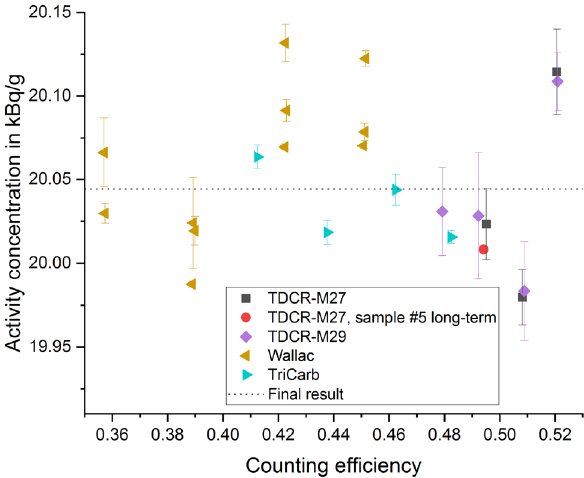
Figure 7. Activity concentration as obtained for the CNET and the TDCR method without data that were discarded. The uncertainty bars represent only a statistical component which was calculated as a standard deviation of the mean of several repetition